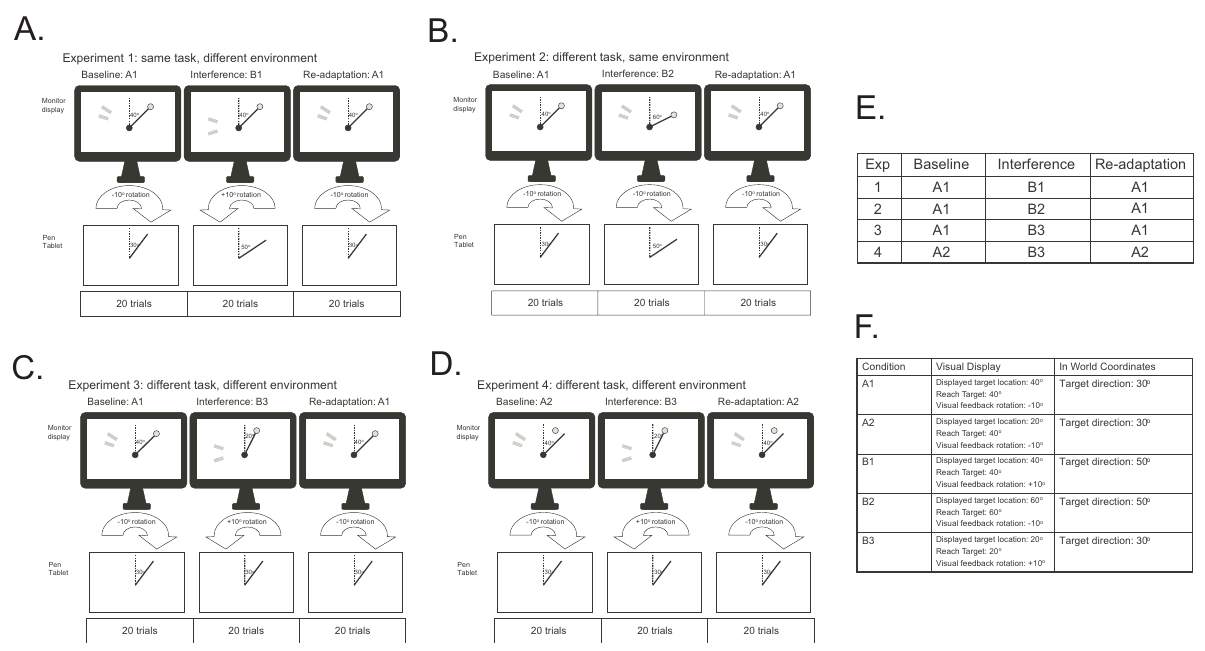
Figure 3. Experimental procedure. In each of the four experiments, there were three blocks, with 20 trials each. In the figure, the monitor represents what the participants saw during the experiment. The rectangle below represents the subjects’ arm movement. The dark circular dot represents the starting location, and the light colored dot represents the target presented to the participants during the experiment. The line in between the dots indicates the desired movement as observed on screen. Two striped marks on the side of the screen always indicate the “west” direction on the tablet, which was used as an indicator to the participants to let them know which environment they are in. Figures A , B , C and D show the experimental setup for experiment 1, 2, 3 and 4 respectively. E and F show details of each experimental